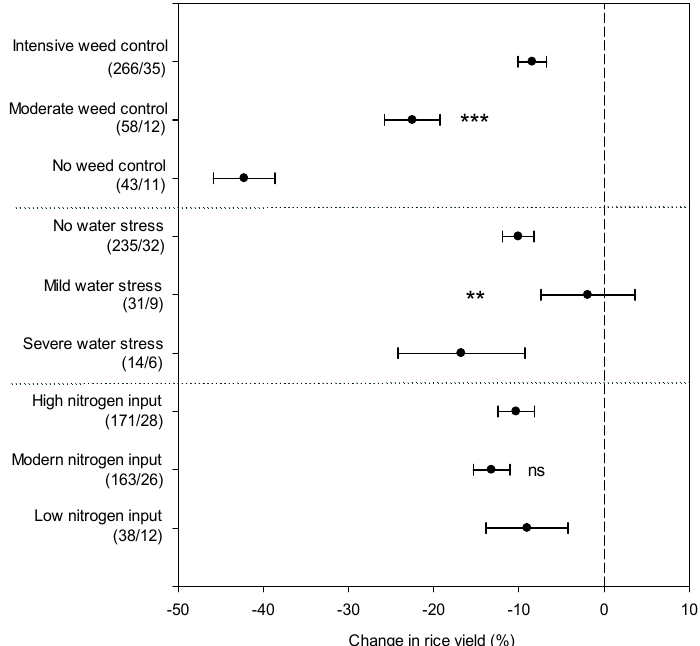
Figure 3. Influence of di ff erent weed infestation, water regimes, and nitrogen input on the yield change of direct-seeded rice relative to transplanted rice. The number of paired observations / number of studies included in each dataset are presented in parenthesis. Significant di ff erences by categories are based on randomization tests. ns denotes non-significance at 0.05, * denotes significant at p ≤ 0.05, ** denotes significant at p ≤ 0.01, and *** denotes significant at p ≤